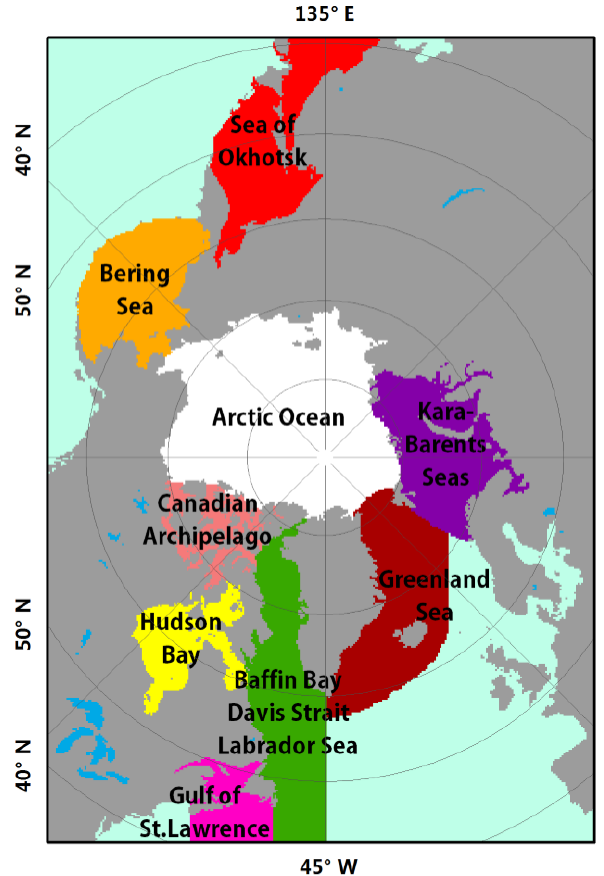
Figure 1. The regional mask around the Arctic provided by the National Snow and Ice Data Center (NSIDC). It includes Arctic Ocean, Barents and Kara Seas, Greenland Sea, Baffin Bay/Davis Strait/Labrador Sea, Gulf of St. Lawrence, Hudson Bay, Canadian Archipelago, Bering Sea, and Sea of